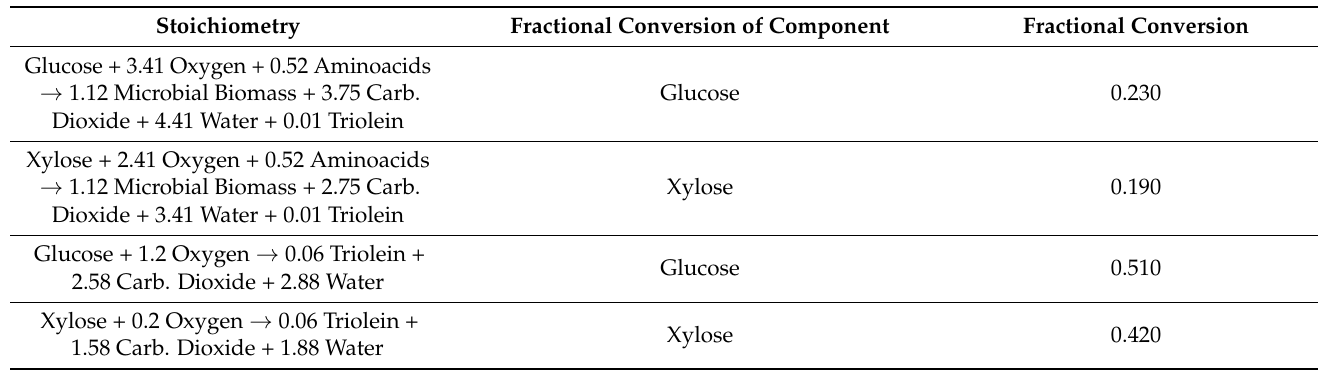
Table 5. Conversion for reaction considered in the lipid fermentation (R6); these reactions occur in series.